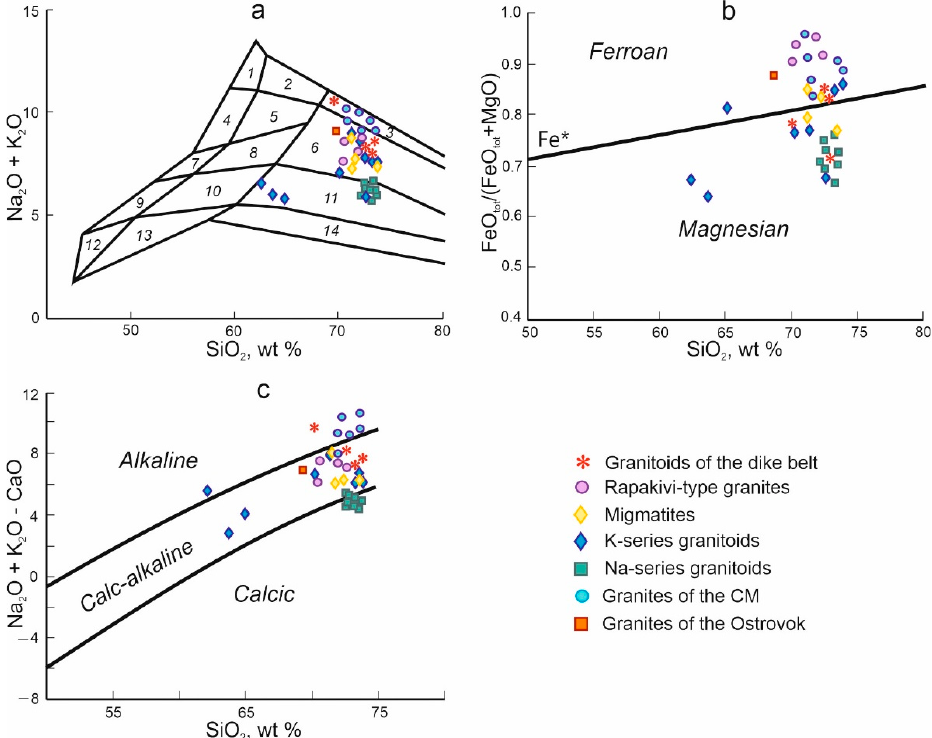
Figure 15. Plots ( a ) (Na 2 O + K 2 O) vs. SiO 2 , ( b ) FeO/(FeO + MgO) vs. SiO 2 , and ( c ) (Na 2 O + K 2 O–CaO) vs. SiO 2 for the GC granitoids. Fields on ( a ): 1—alkaline syenites, 2—alkaline quartz syenites, 3—alkaline granites, 4—syenites, 5—quartz syenites, 6—granites; 7—monzonites, 8—quartz monzonites, 9—monzodiorites, 10—quartz monzodiorites, 11—granodiorites, 12—gabbros, 13—quartz diorites, and 14—tonalities.